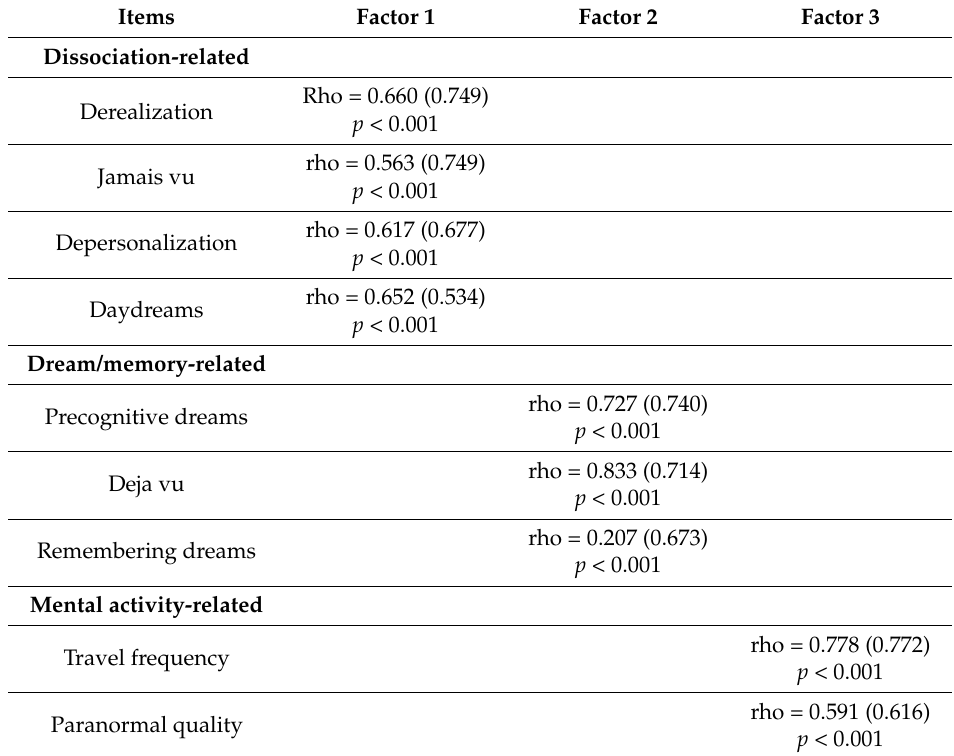
Table 4. Factor analysis of the IDEA